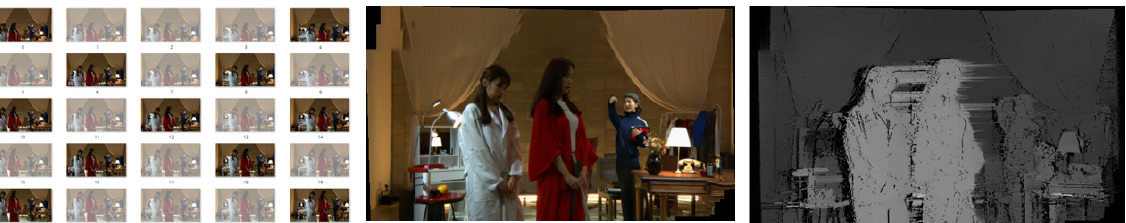
Figure 18. View synthesis with 11 images is extended in the vertical and horizontal